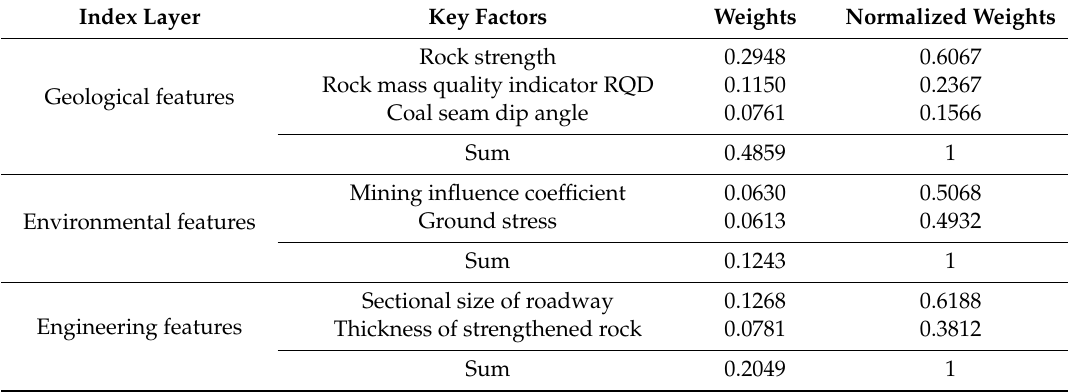
Table 7. The normalized weights of key